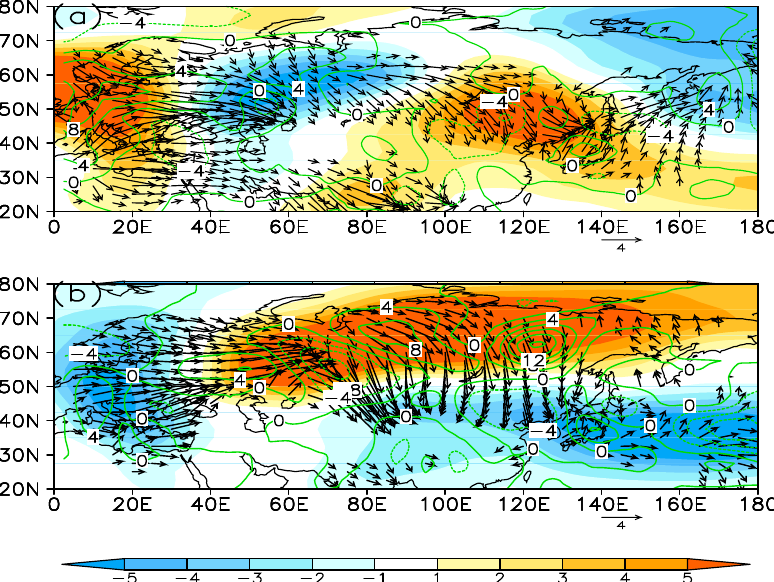
Figure 8. The 500 hPa horizontal wave activity flux (vectors), vertical wave activity flux (contour, 10 3 ), and geopotential height anomaly (shading, units: dgpm) in January in higher haze-fog years ( a ) and lower haze-fog years ( b ).